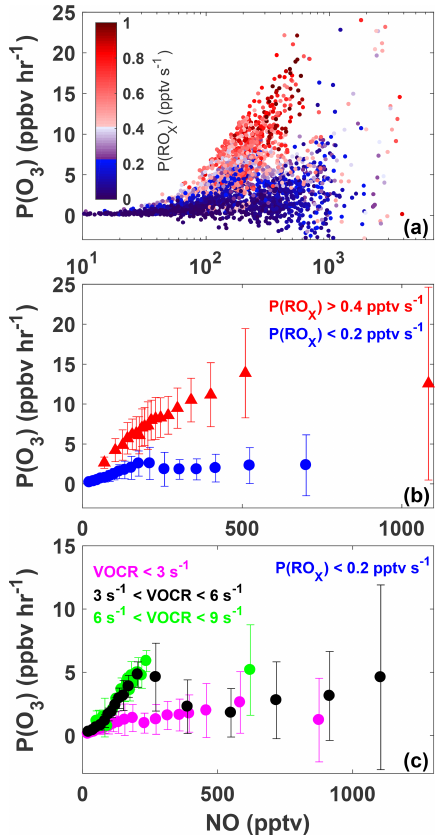
Figure 6. The variation of P( O 3 ) with NO for all daytime ob- servations (07:00 to 20:00) made during SAFS (a) . Observations are colored by P( RO x ) . The same data as shown in panel (a) but sorted by P( RO x ) are shown in panel (b) . Observations with P( RO x ) greater than 0.4pptvs − 1 are shown in red, while obser- vations with P( RO x ) less than 0.2pptvs − 1 are shown in blue. Data are separated into NO bins with an equal number of obser- vations per bin. The mean value of each bin is shown, with the error bars showing 1 standard deviation. The subset of observa- tions with P( RO x )< 0 . 2pptvs − 1 is further separated into three categories: low VOC reactivity (VOCR < 3s − 1 ; magenta), medium VOC reactivity (3 < VOCR < 6s − 1 ; black), and high VOC reactiv- ity (6 < VOCR < 9s − 1 ; green) (c) . As in panel (b) data are sepa- rated into NO bins with equal numbers of observations in each